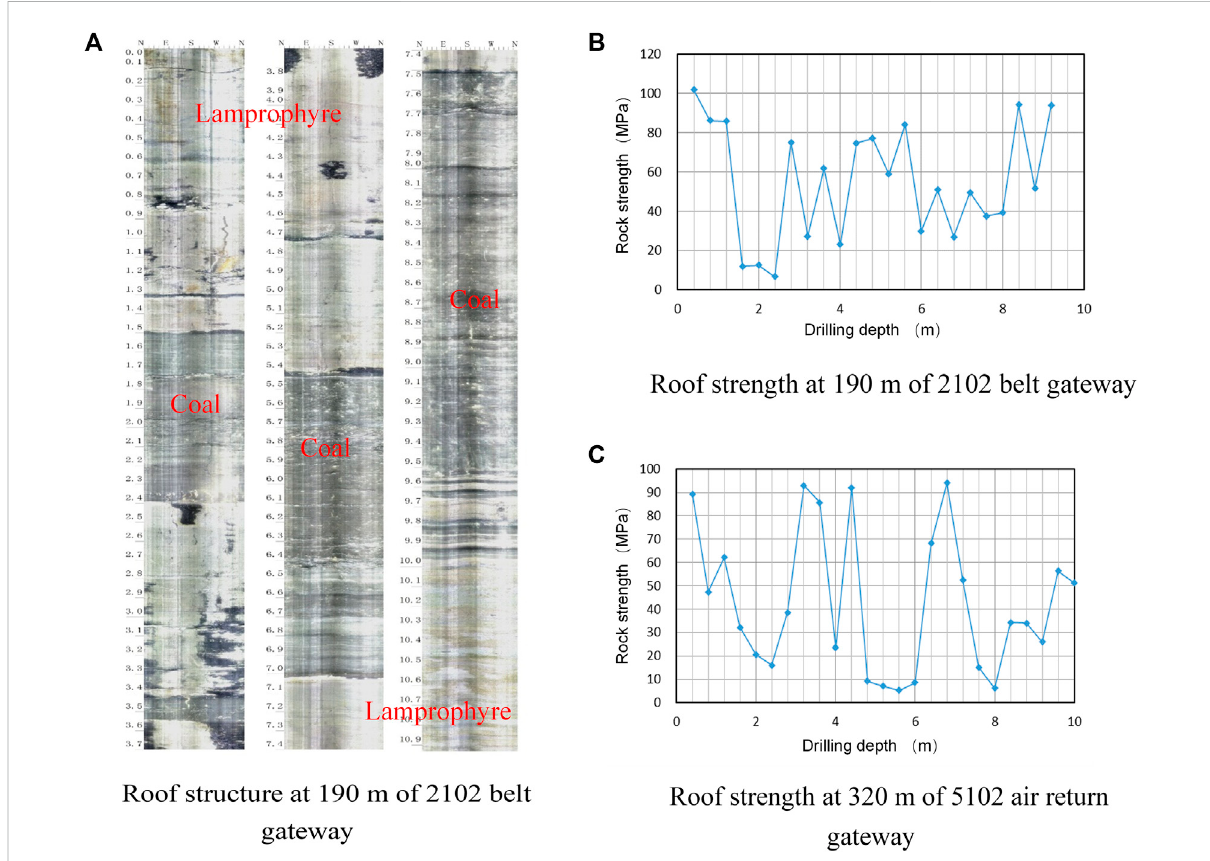
FIGURE 4 Structure and strength test of underground surrounding rock in Dongzhouyao coal mine. Roof structure at 190 m of 2102 belt gateway. Roof strength at 190 m of 2102 belt gateway. Roof strength at 320 m of 5102 air return gateway.